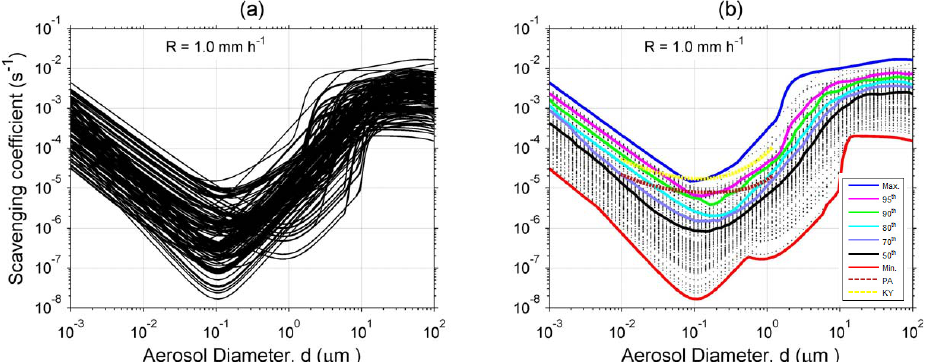
Fig. 4. Size-resolved scavenging coefficient under snow conditions: (a) 3 snow calculated using Eq. (2) from a total of 168 combinations of E(d,D p ) , N(D p ) , V D and A listed in Tables 4, 5, 6, and 7, respectively; and (b) minimum, maximum, and five percentile 3 snow profiles (colored lines) based on ensemble of profiles from (a), where dots are the data from (a) . Also shown in (b) are two empirical 3 snow formulas of Paramonov et al. (2011) and Kyrö et al. (2009) (Appendices C and D, respectively). Table 6. List of empirical and theoretical snow particle terminal velocity ( V D ) formulas. X is the best number: X = 2 mgρ a D σ are empirical constants (see Table 7), and a 1 and b 1 are described as functions of X (see Mitchell and Heymsfield, 2005).